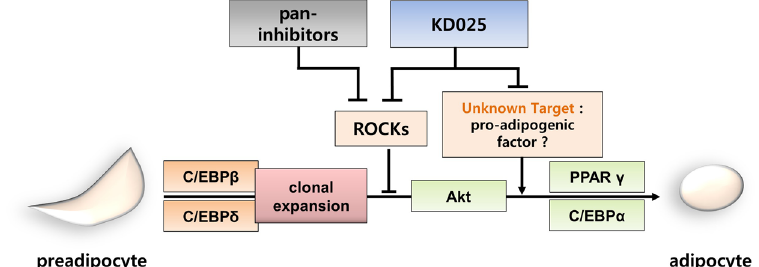
Figure 9. Model of the effects of KD025 on 3T3-L1 adipocyte differentiation. KD025 inhibits adipocyte differentiation in 3T3-L1 cells, regulating the intermediate stage of this process. Differentiation is not promoted by the suppression of ROCK2 activity via KD025. This anti-adipogenic effect of KD025 might be mediated by the suppression of an unknown key pro-adipogenic